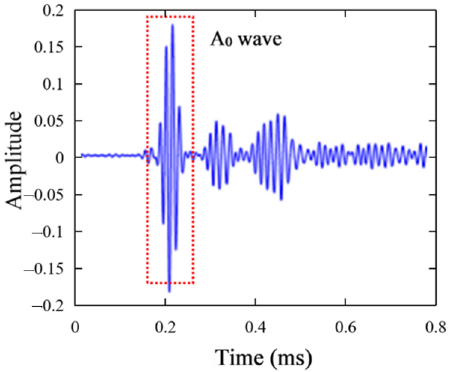
Figure 18. Narrowband signal extracted by wavelet transform.